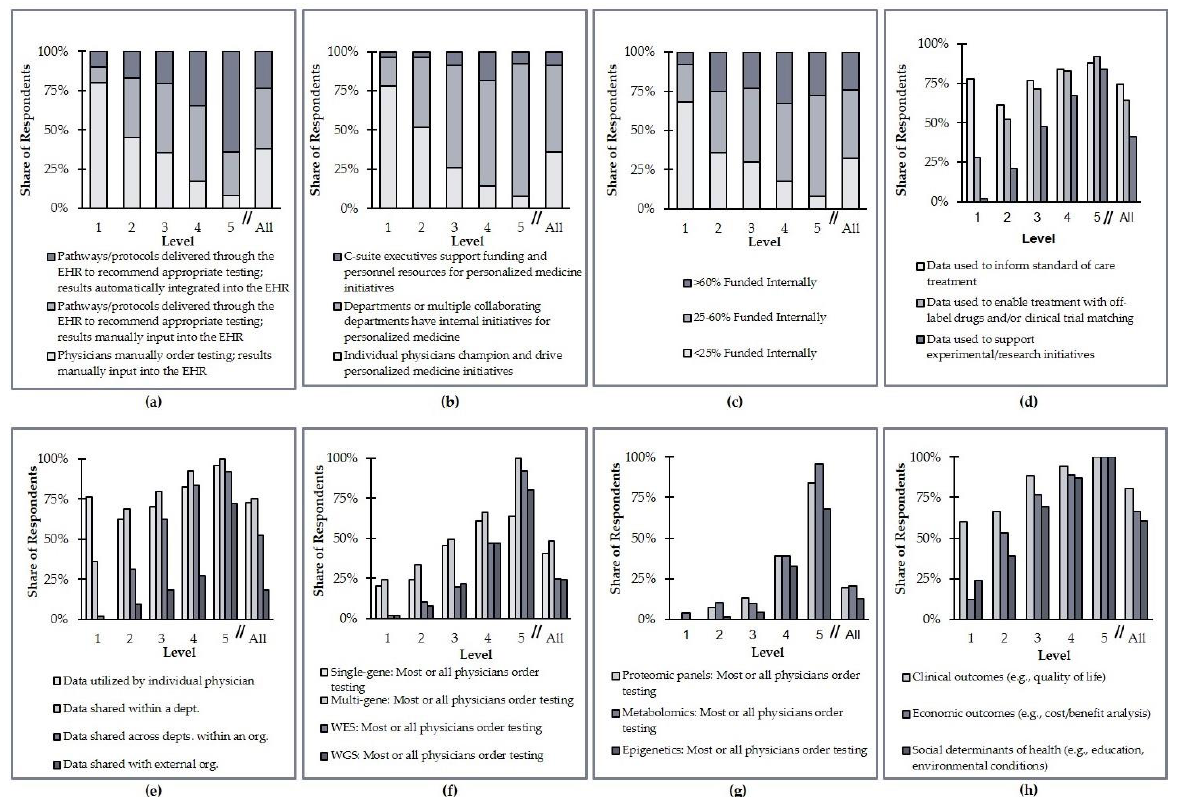
Figure 5. US health system distribution of the overall level of personalized medicine integration by criteria. ( a ) Testing guidance and data accessibility; ( b ) leadership; ( c ) internal funding of personalized medicine; ( d ) utilization of data; ( e ) data sharing; ( f ) collection of genomic data; ( g ) collection of other omics data; ( h ) collection of non-laboratory data.